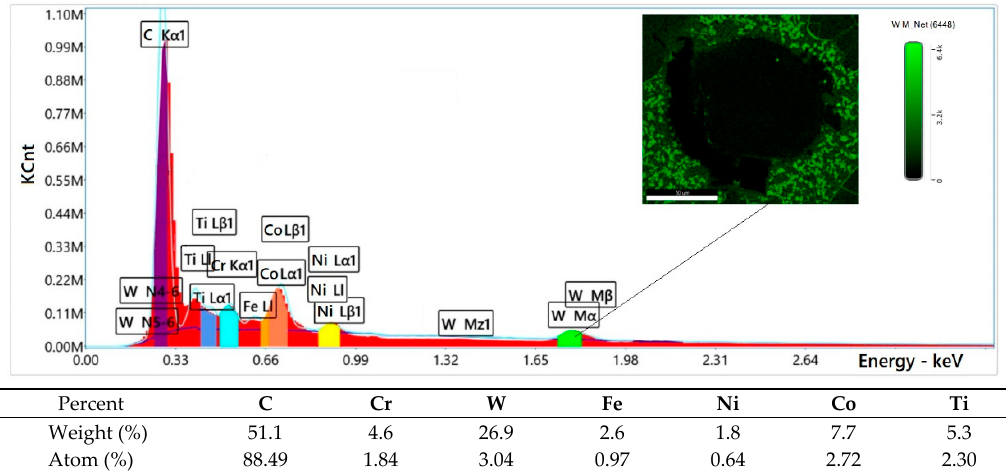
Figure 8. Diagram of scattered X-radiation energy with energy lines present in area 1 (Figure 7a) of the analyzed components (chemical elements).